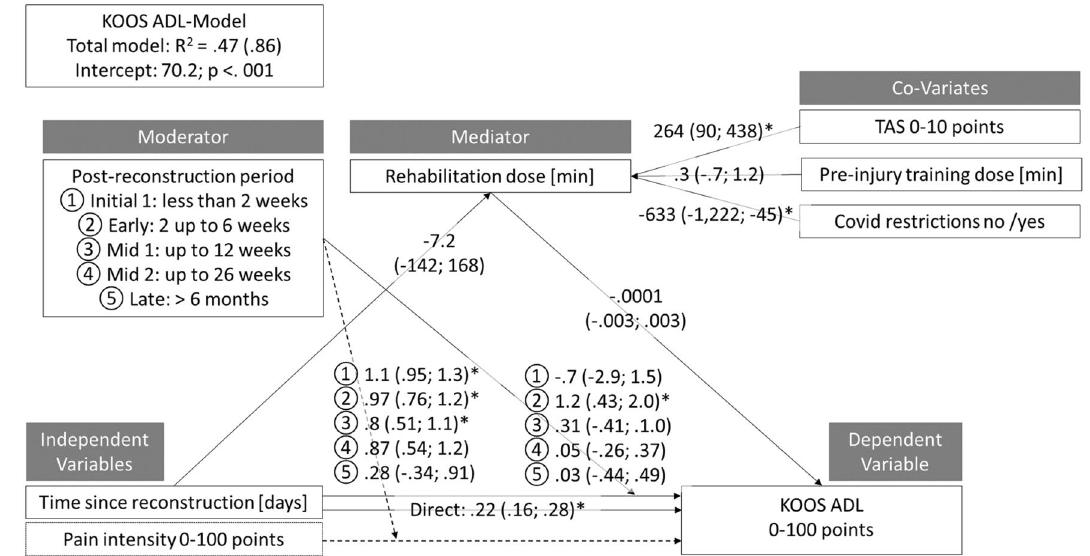
Figure 2. Moderated mediation model outcomes for the dependent variable KOOS ADL. Coefficients and their confidence intervals (lower limit; upper limit) are displayed for direct, conditional direct, total and indirect effects of pain and time since reconstruction. The moderation effects of the different rehabilitation phases on the regression of pain intensity (left column) and time since reconstruction (right column) on KOOS ADL are displayed, likewise. Asterisks (*) display a significant interaction. TAS Tegner activity scale, min minutes, R 2 variance explanation without (and, in brackets, variance explanation with) pain intensity as a